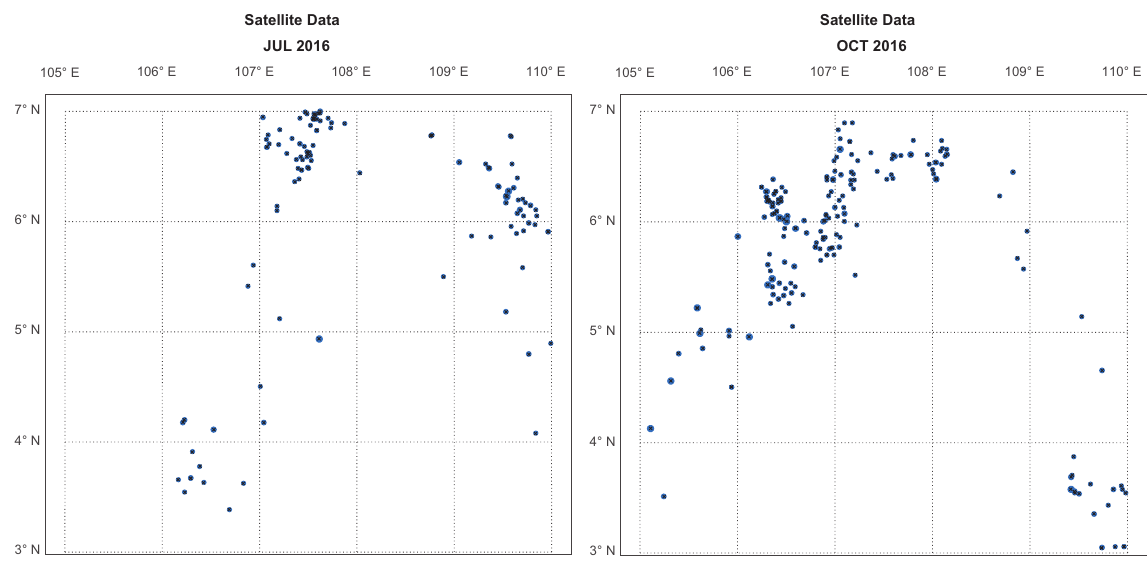
Figure 1. Ships doing fishing activities in Natuna Sea over years